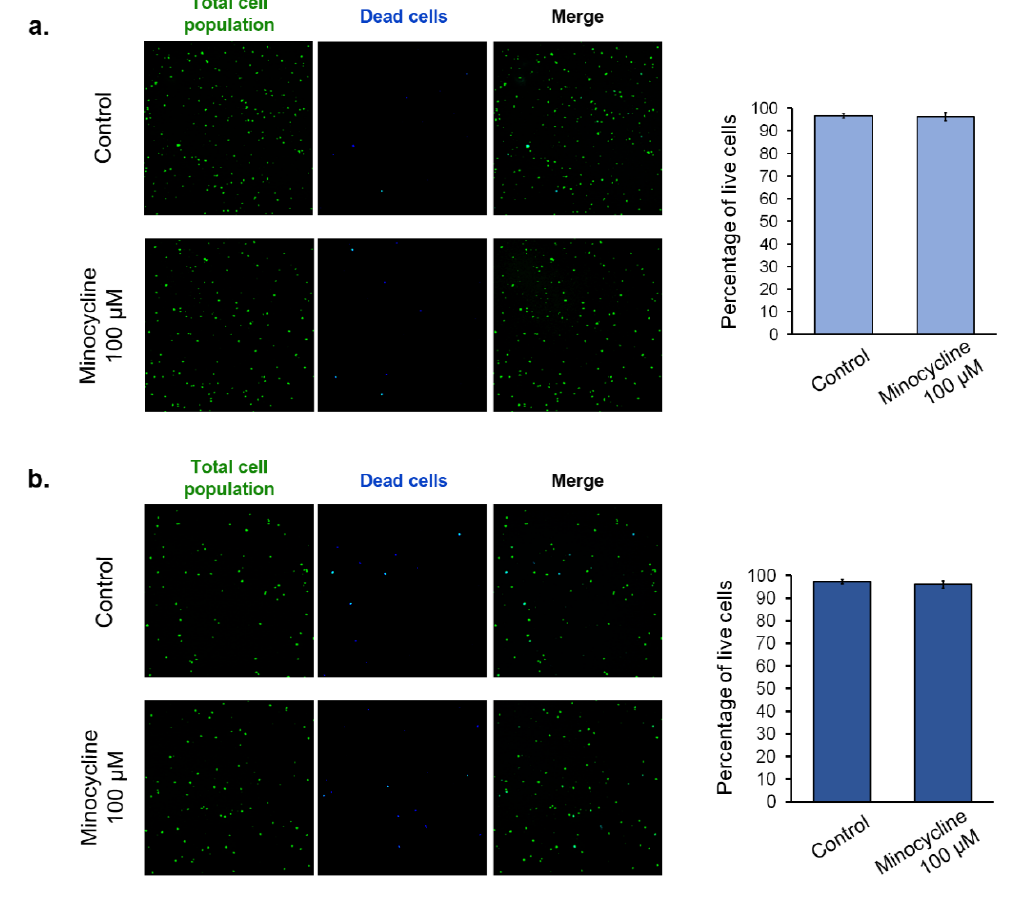
Figure 4. The influence of minocycline on the viability of human normal epidermal melanocytes. Lightly pigmented ( a ) and darkly pigmented ( b ) melanocytes were treated with 100 µM of minocycline for 48 h. Representative pictures of stained, non-fixed cells are presented. The results of the viability are shown as the percentage of live cells in the tested population.